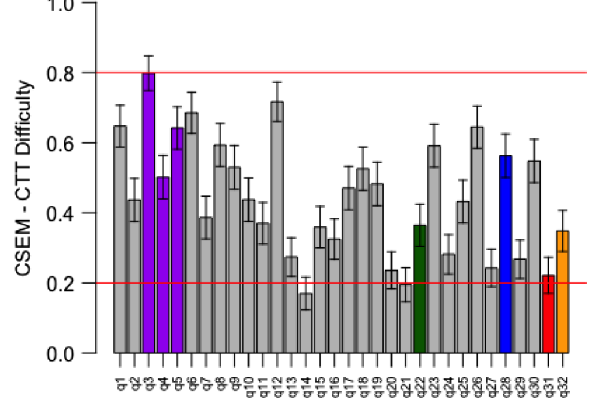
FIG. 3. The error bars are (cid:2) 2 standard deviations from 10 000 randomly sampled classes of 250 students from the full sample for the CSEM. The horizontal red lines indicate the range of ideal difficulties for well-functioning questions. The colored bars are the 7 identical items between the BEMA and